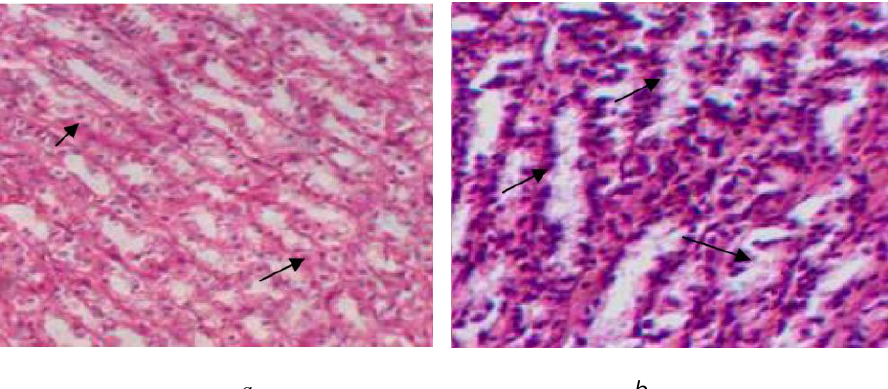
а b Fig. 5. The stomach of the rat, which was injected alcohol-prednisolone mixture: a – vacuolization of the cytoplasm of the parietal cells of the prepyloric part; b – expansion of the lumen of the basal divisions of its own glands, reduction of the secretory zone and basophilia of the cytoplasm of the main cells, residues of secretion in the lumen. Haematoxylin- eosin. ×250.